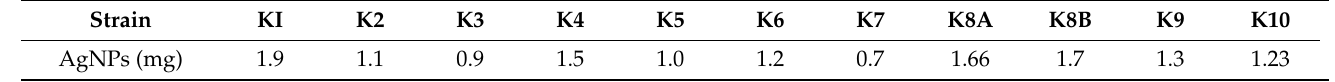
Table 1. Concentration of nanoparticles synthesized from different fungal